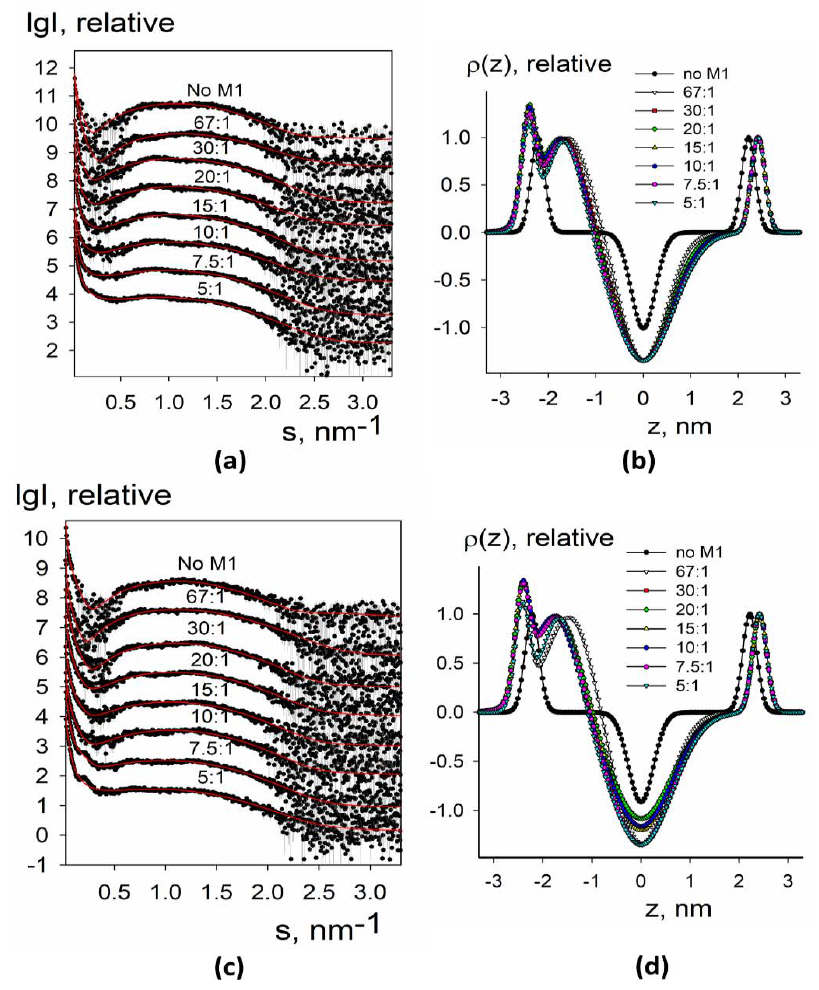
Figure 3. SAXS and BILMIX analysis of synthetic liposomes composed of 10 mol.% DOPS + 90% mol. DOPC ( a , b ) or 30 mol.% DOPS + 70 mol.% DOPC ( c,d ) lipid mixtures loaded with M1 protein. ( a , c ) Experimental small-angle scattering data are represented by dots with error bars. The best fits of the SAXS curves obtained by BILMIX program are shown by solid red lines. The curves are shifted by one logarithmic order for better clarity; ( b, d ) the restored electron density profiles of the lipid bilayer before (black curve) and after (color curves) loading with M1. The molar lipid/M1 ratios are the following: no M1, 67:1, 30:1, 20:1, 15:1, 10:1, 7.5:1, 5:1.